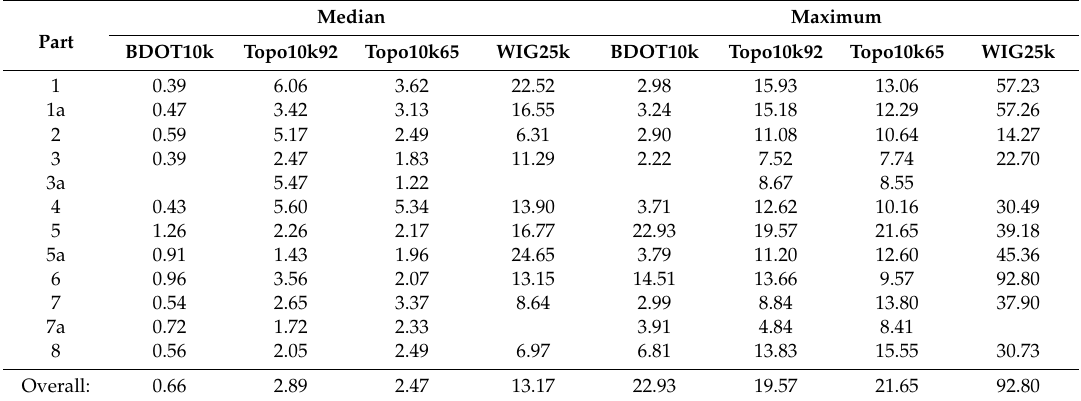
Table 6. Distances of the Pr ˛adnik River parts with reference to the ONP watercourses (ONPw) layer. Median Maximum Part 1